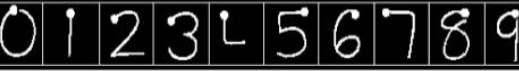
Figure 1. Palm’s Graffiti